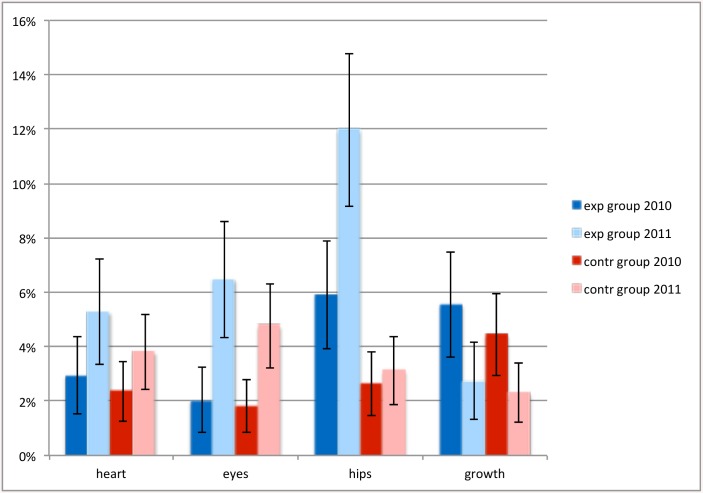
Percentage of children with abnormal findings.A comparison is shown between abnormal findings of heart, eyes, hips and growth, in experiment and control region, before and during the experiment. The 95% confidence intervals are indicated by black error bars.